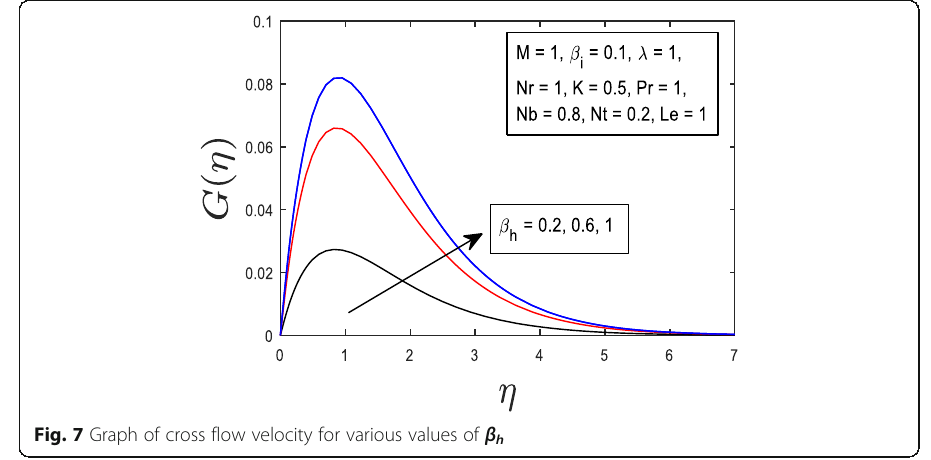
Fig. 7 Graph of cross flow velocity for various values of β h